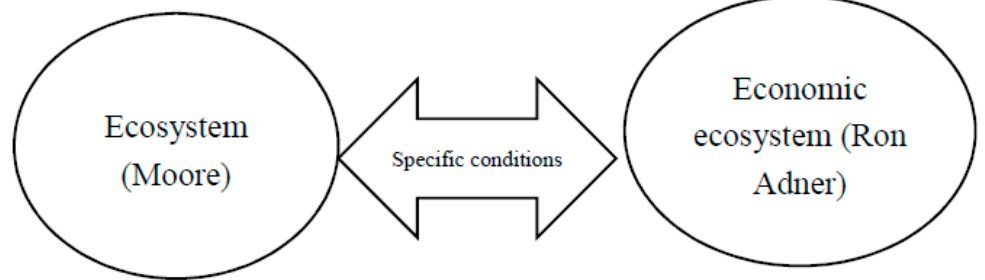
Figure 2. Interrelation of definitions for an ecosystem developed by Moore and Ron Adner.